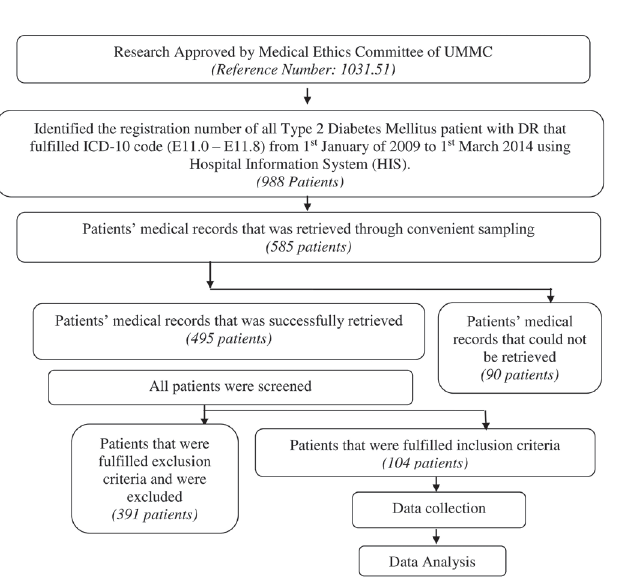
FIGURE 1 - Overview of methodology. TABLE I - Definitions used in the study